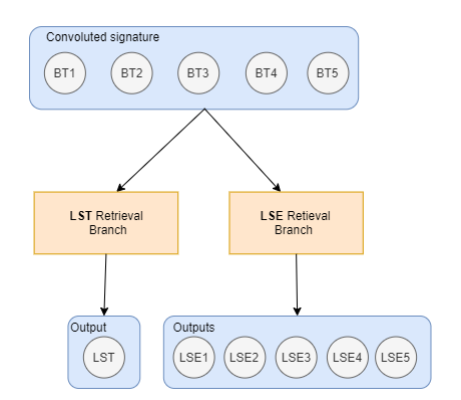
Figure 2. NN structure.